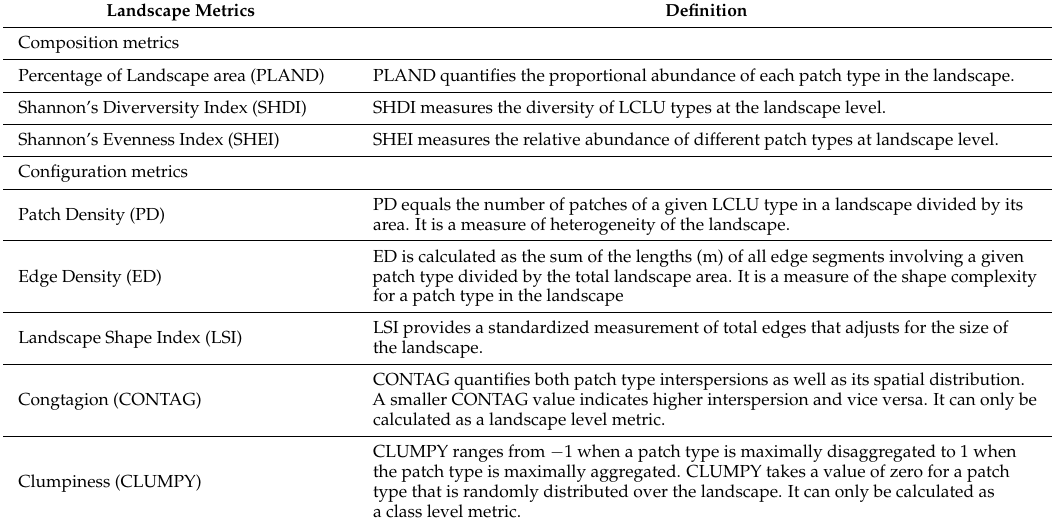
Table 3. Landscape pattern metrics used in this study, after McGarigal et al.